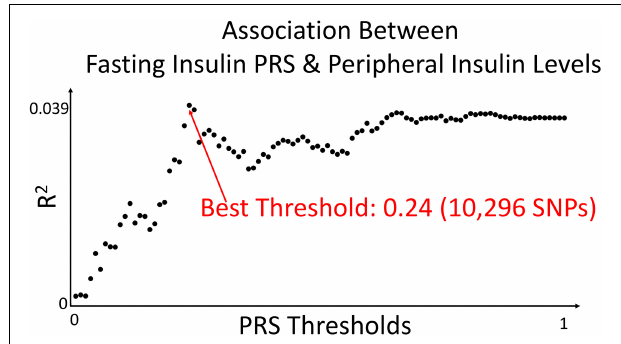
FIGURE 4 | Association between fasting insulin PRS and peripheral insulin levels. We calculated polygenic risk scores from the fasting insulin GWAS at 100 different thresholds. Using ALSPAC as a discovery cohort, we identified the PRS threshold with the strongest correlation in predicting peripheral insulin levels in children at age 8.5 years. The strongest (R 2 = 0.039) and most significant ( p = 0.071) association was identified to be 0.24 in children at age 8.5 years in the ALSPAC cohort [ N = 467; p t − initial = 0.24 (10,296